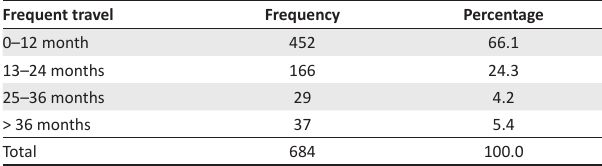
TABLE 7: Frequency of travel.